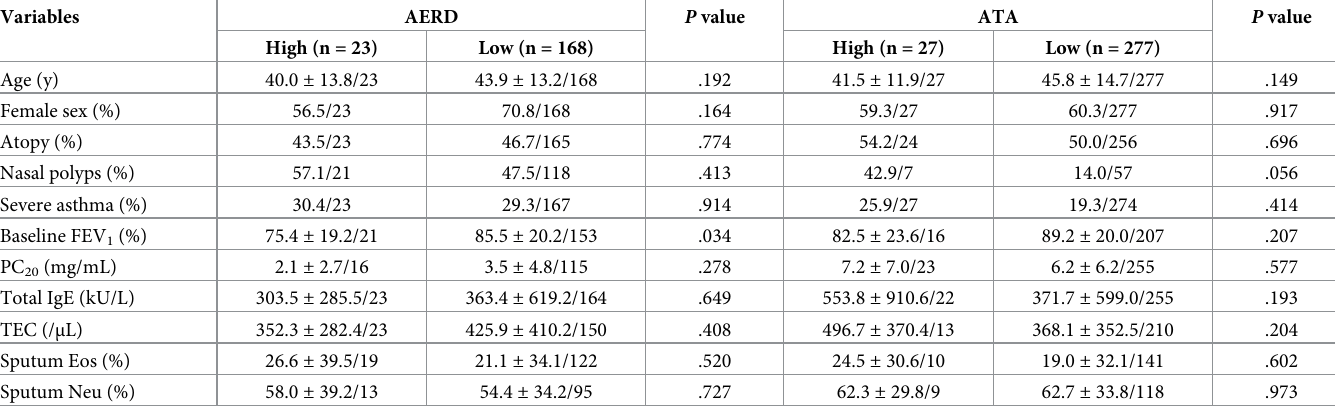
Table 2. Characteristics of asthmatic patients with high ( � 48.1 ng/mL) and low TGF- β 1 ( < 48.1 ng/mL) levels in the first cohort. Variables AERD P